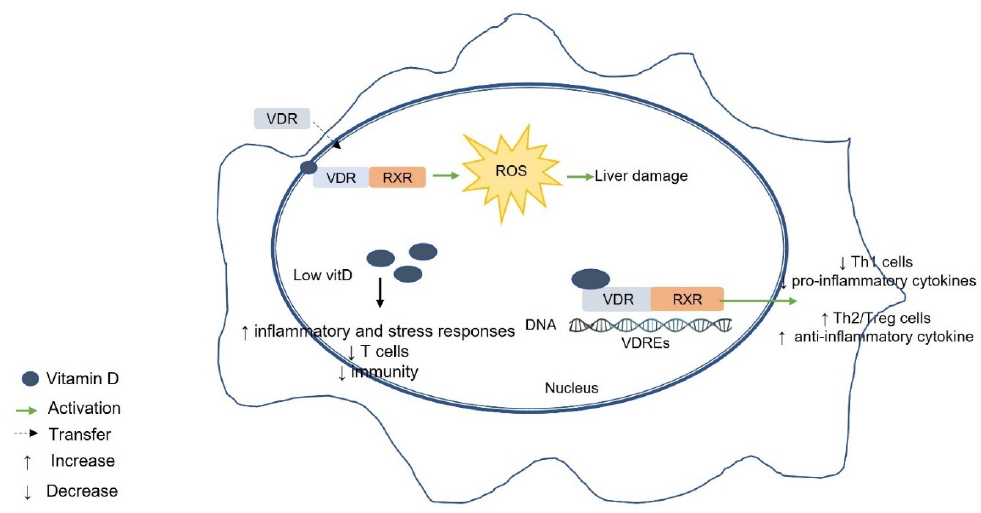
Figure 3. Vitamin D–VDR-mediated effects on autoimmune hepatitis (AIH). Low vitamin D levels and increased inflammatory and stress responses lead to decreased T-cell subpopulations and impaired immunity in AIH patients. VDR signaling leads to a rapid increase in ROS, which could be detrimental to the liver in AIH. VDR, vitamin D receptor; RXR, retinoid X receptor; VDRE, vitamin D response element; Th1, T helper 1; Th2, T helper 2; Tregs, T regulatory cells; ROS, reactive